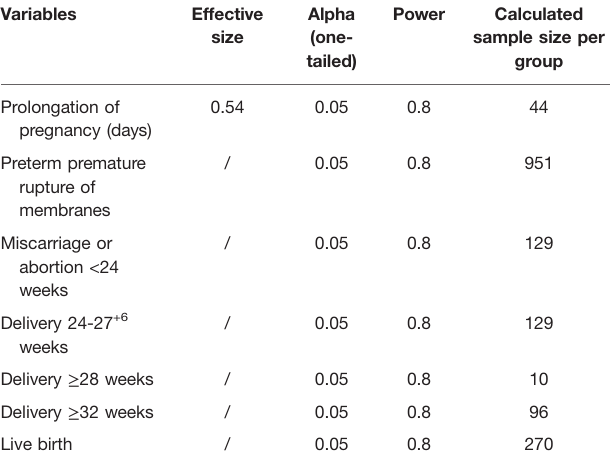
TABLE 3 | Sample size calculation based on the present